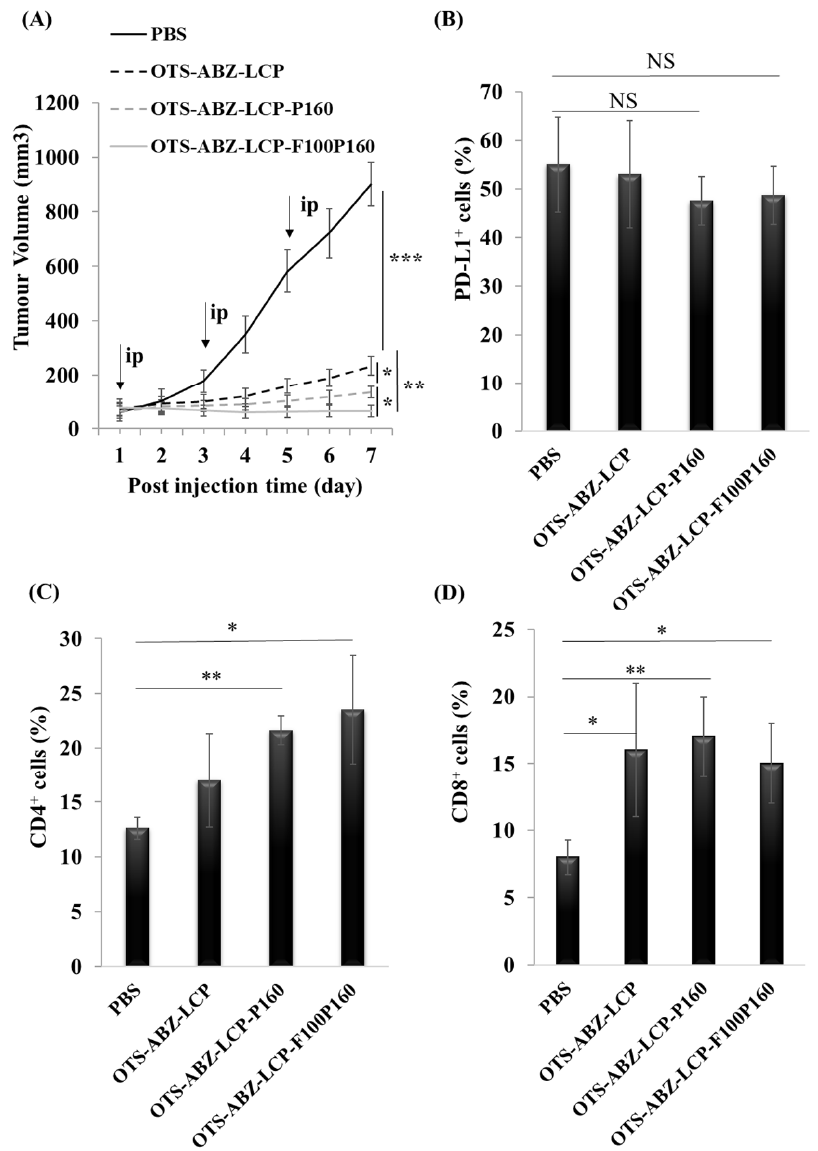
Figure 7. Improved chemotherapeutic outcomes by dual ligand targeting. ( A ) Tumour growth profile reflecting in vivo antitumour efficacy of OTS-ABZ-LCP, OTS-ABZ-LCP-P160 and OTS-ABZ-LCP-F100P160 (equivalent 2.5 mg/kg of albendazole and 1 mg/kg of OTS in all formulations) intraperitoneally injected 3 times every 2 days in the B16F0-bearing mouse model compared to that of PBS injection; ( B ) PD-L1 expression by excised tumour cells; ( C ) CD4 + and ( D ) CD8 + immune cell populations in tumour tissues.